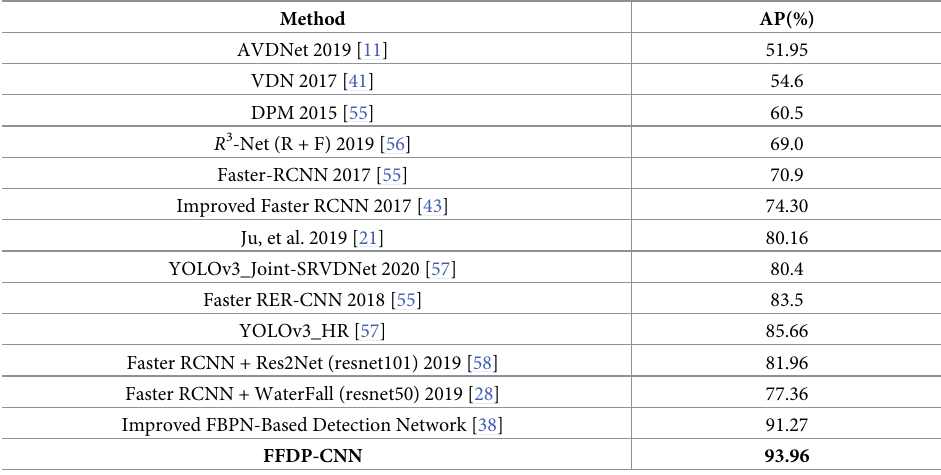
Table 10. Comparison between proposed framework and other methods on